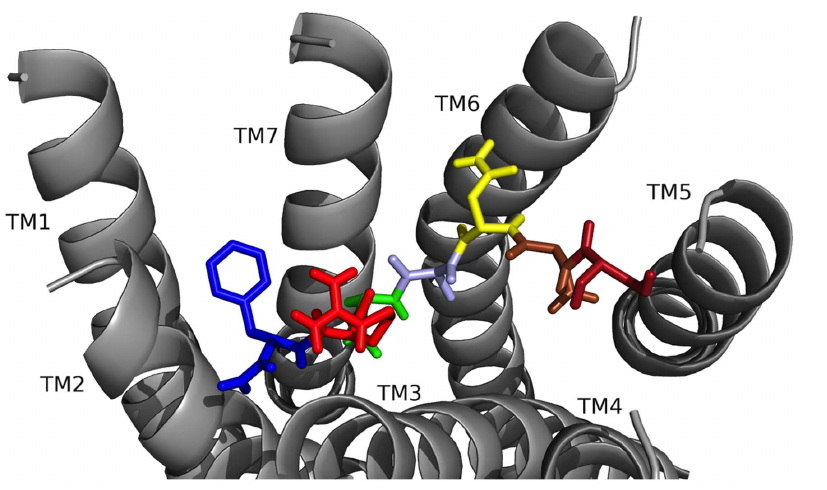
Figure 11. SDNAMRF-NH 2 docked to FMRFa-R. Contacts between the amino acids in SDNAMRF-NH 2 are shown as S (brick red), D (tan), N (yellow), A (sky blue), M (green), R (red), and F7 (blue) and the receptor, FMRFa-R, whose transmembrane regions are labeled TM # where # is 1–7. The C-terminal F was amidated, -NH 2 .